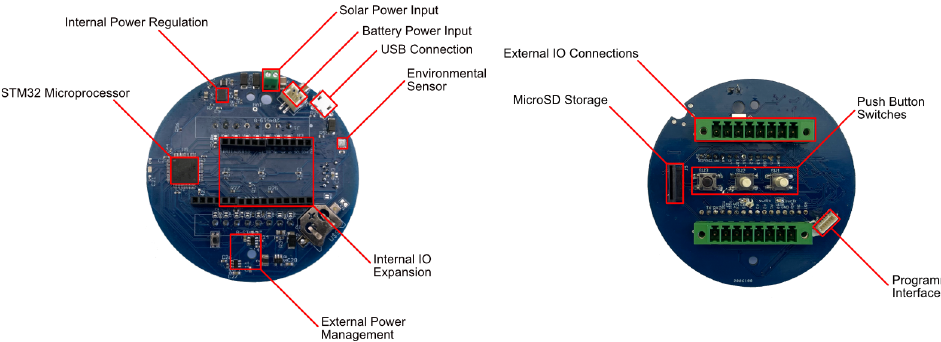
Figure 2. An overview of the motherboard that serves as the central hub of the